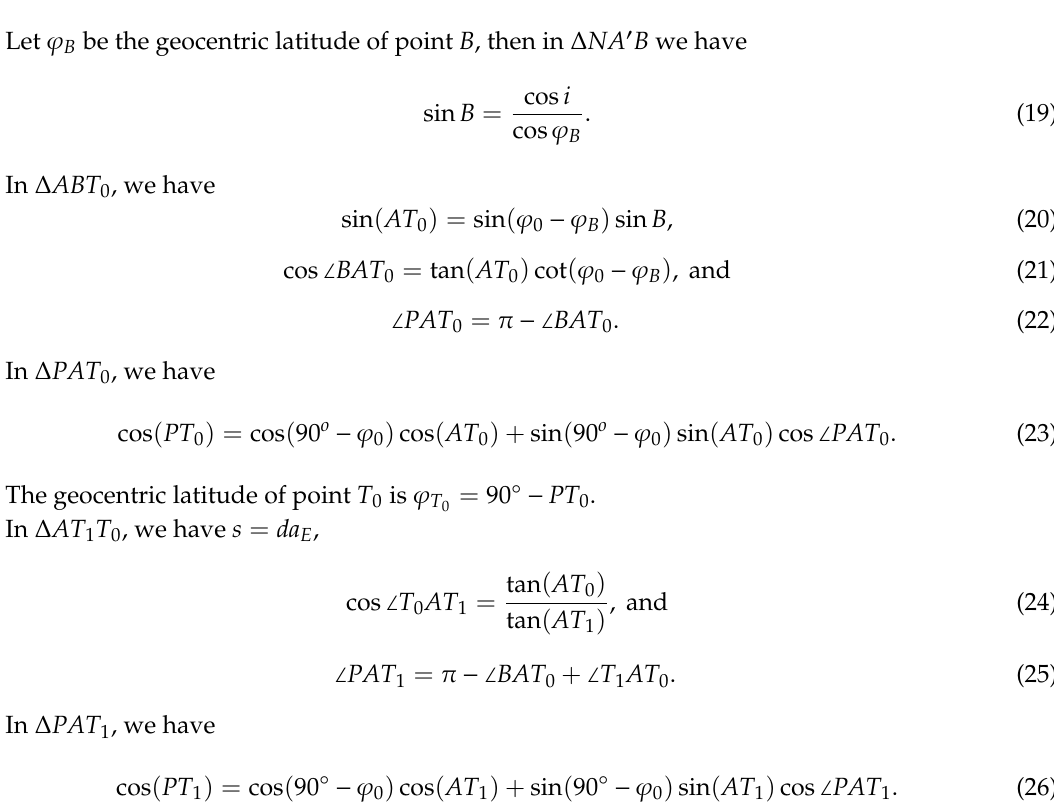
Figure 6. The time window of a low Earth orbit (LEO) satellite.